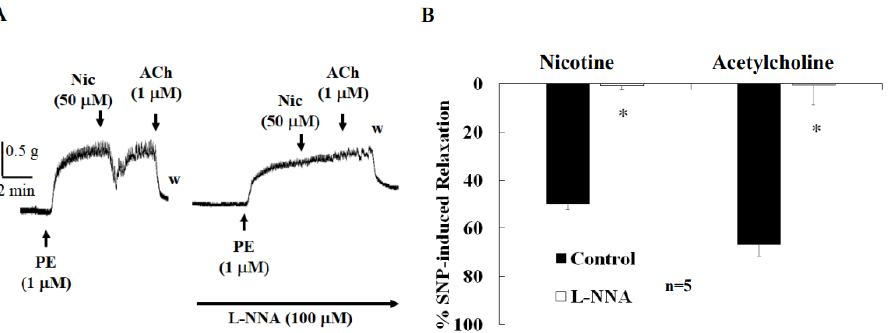
Figure 5. Effect of nitric oxide synthase inhibitor N G -nitro-L-arginine on corpus cavernosum relaxation . The representative tracing in ( A ) shows that the corpus cavernosum (CC) is precontracted by phenylephrine (PE, 10 μM). The relaxation induced by nicotine (50 μM) and acetylcholine (ACh, 10 μM) was inhibited by N G -nitro-L-arginine (L-NNA, 100 μM). ( B ) Summary data showing the effects of L-NNA on corpus cavernosum (CC) strips ( n = 5, p < 0.05). ACh- and nicotine-induced CC smooth muscle relaxation were estimated as a percentage of sodium nitroprusside (SNP, 0.1 mM)- induced maximum relaxation. n , number of experiments. Values are means ± SD. The asterisk indi- cates a significant difference in the paired t -test (* p < 0.05) vs. the control group.